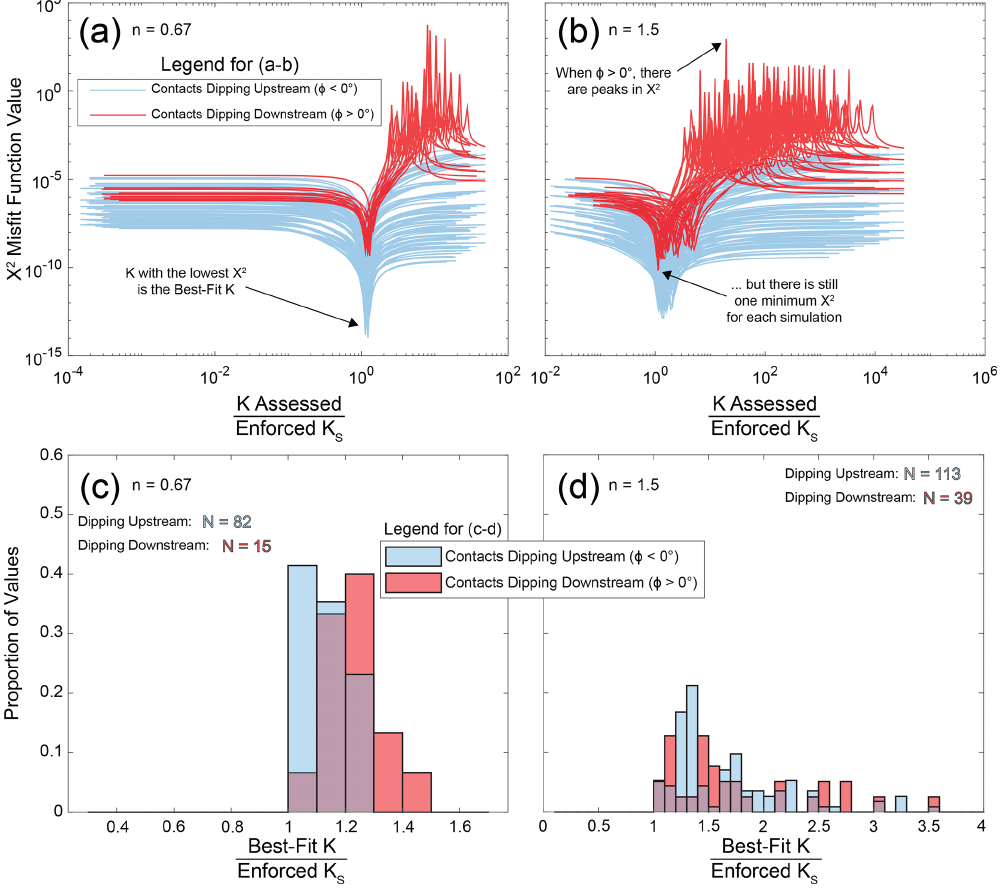
Figure 13. Comparison of best-fit K values in our numerical models to the strong erodibility ( K S ) used in each simulation. (a, b) X 2 misfit function values for kinematic wave speeds ( C H ) estimated using Eq. (12), the enforced contact dip ( φ ), and a wide range of K values (200 points spaced logarithmically from 10 − 9 to 10 − 4 m 1 − 2 nθ yr − 1 , where θ = 0 . 5) relative to the Eq. (13) estimates of C H . (c, d) Com- parison between the best-fit K and the K S enforced in the simulations. Panels (a) and (c) show results for n = 0 . 67, while panels (b) and (d) show results for n = 1 .